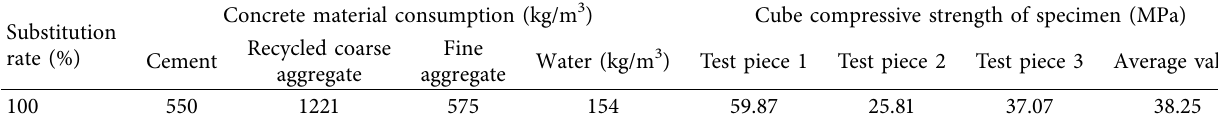
Table 2: Content of each component and measured strength of recycled concrete.